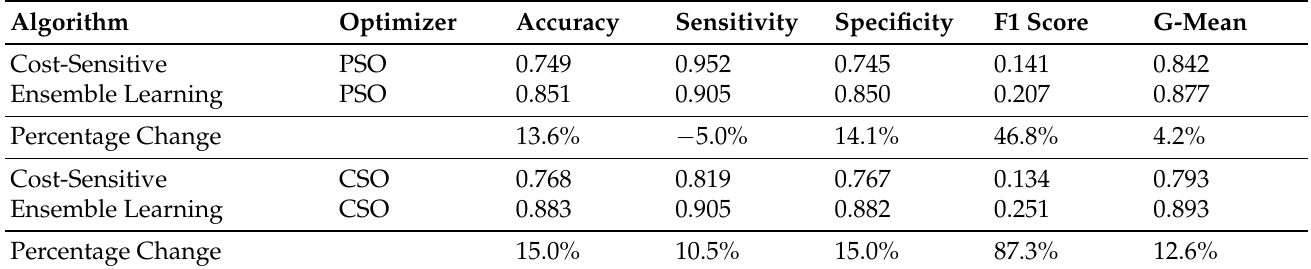
Table 12. A comparison between the results of the evaluation metrics from the cost-sensitive MHOANN and those from the cost-sensitive MHOANN within the majority voting ensemble learning system using the dataset of Spanish companies.